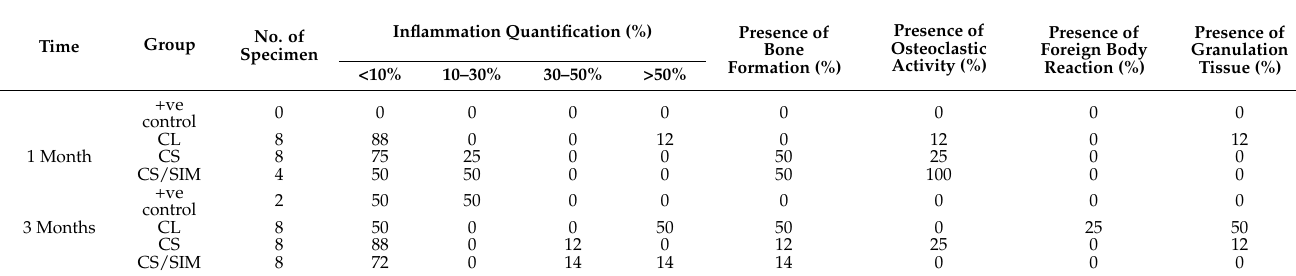
Table 1. Histological section outcome of perforation repair with different test scaffolds.